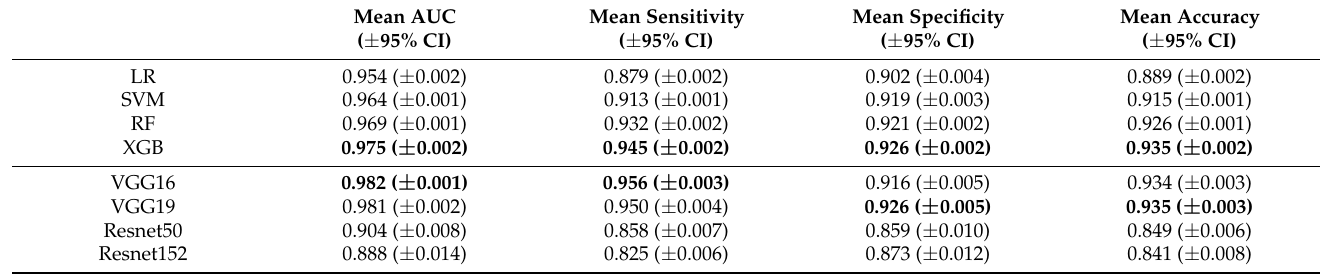
AUC, area under a receiver operating characteristic curve; CI, confidence interval; LR, logistic regression; SVM, support vector machine; RF, random forest; XGB, extreme gradient boost. The highest performance values are shown in